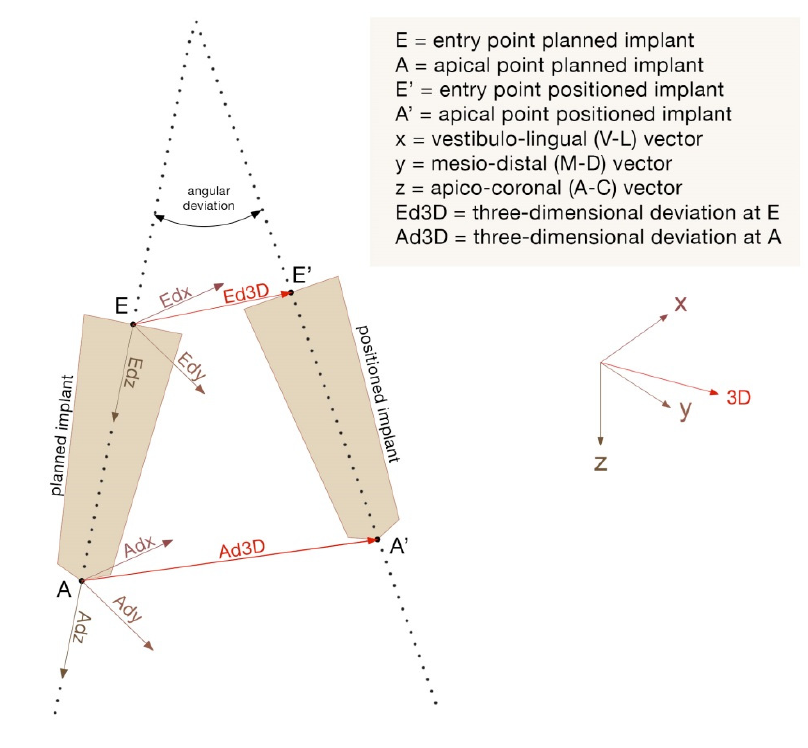
Figure 5. Representation of the 2D, 3D and angular deviations.